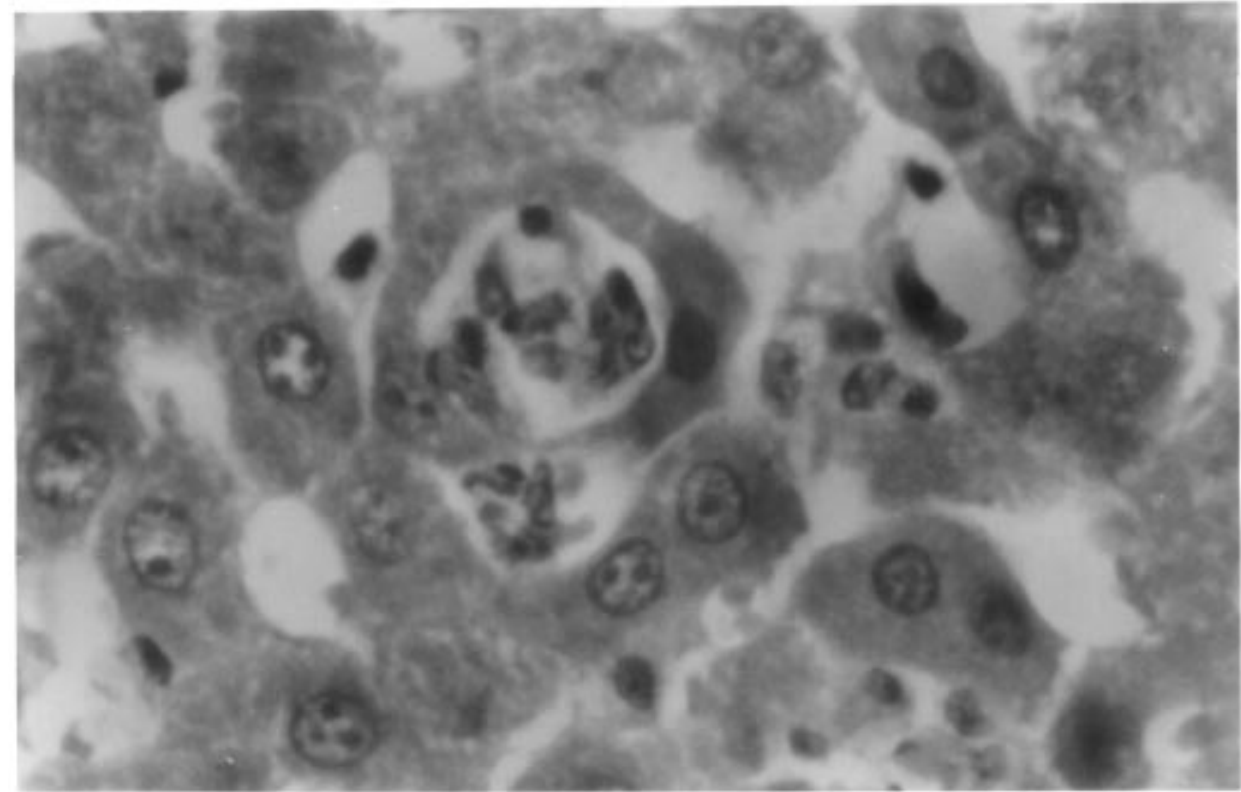
Figure 2 - Liver biopsy 48 h after induction of acute pancreatitis showing lobular focal necrosis and mononuclear inflammatory cell infiltrates. H+E. 400X.